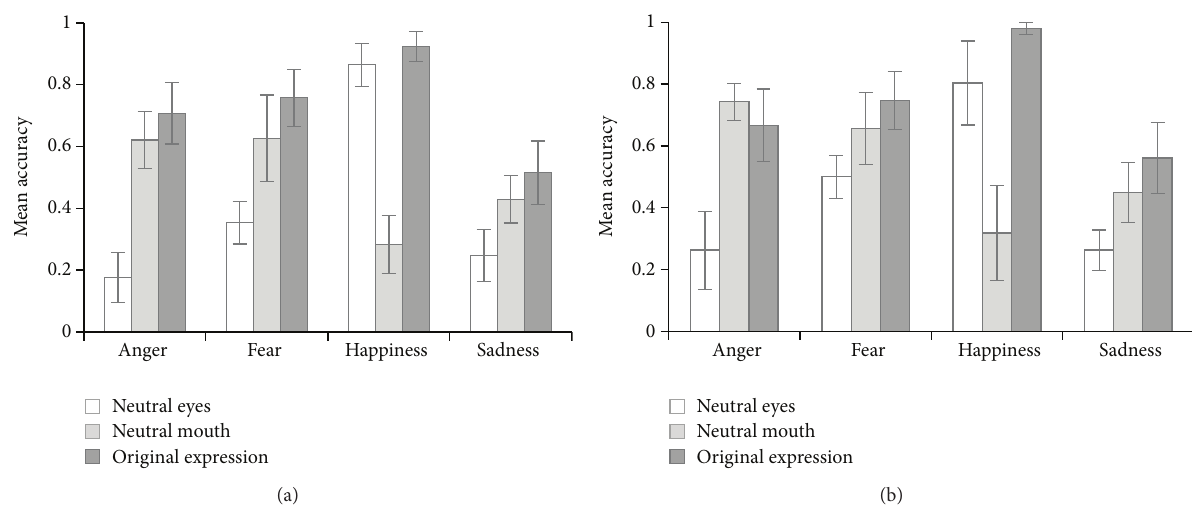
Figure 3: The effect of stimulus presentation (hybrid expression with neutral eyes, hybrid expression with neutral mouth, and original expression) on emotion recognition performance was similar in both the ASD group (a) and in the TD group (b). Happiness is a bottom- emotion; sadness, anger, and fear are top-emotions. Error bars represent 95% confidence intervals of the means.